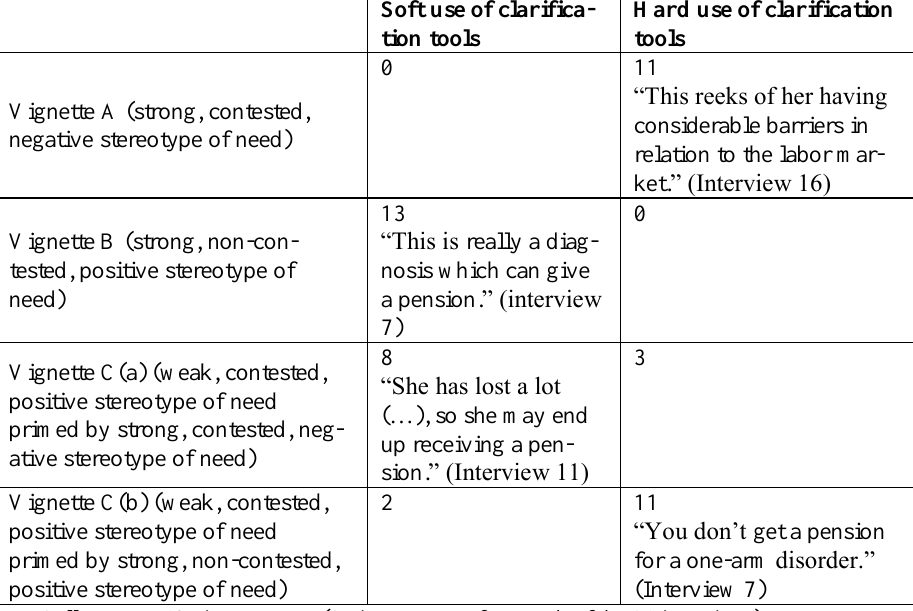
Soft use of clarifica- tion tools